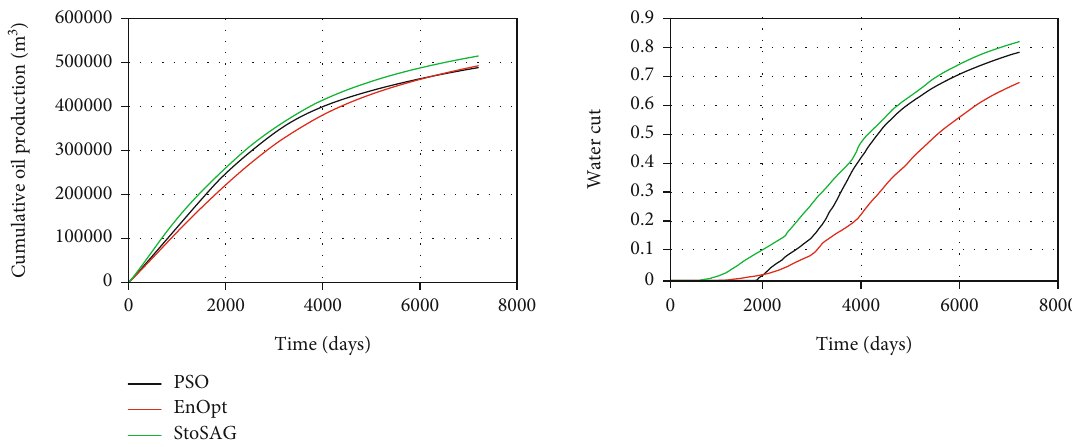
Figure 24: Cumulative oil production and water cut for di ff erent optimization